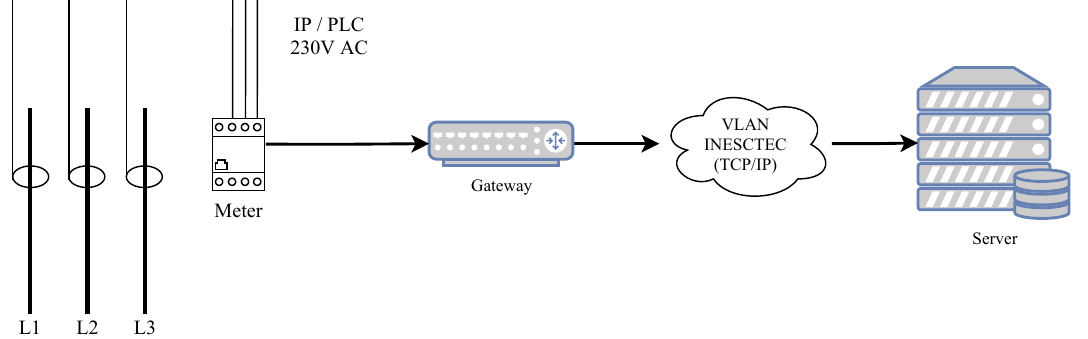
Figure 3. Measurement data